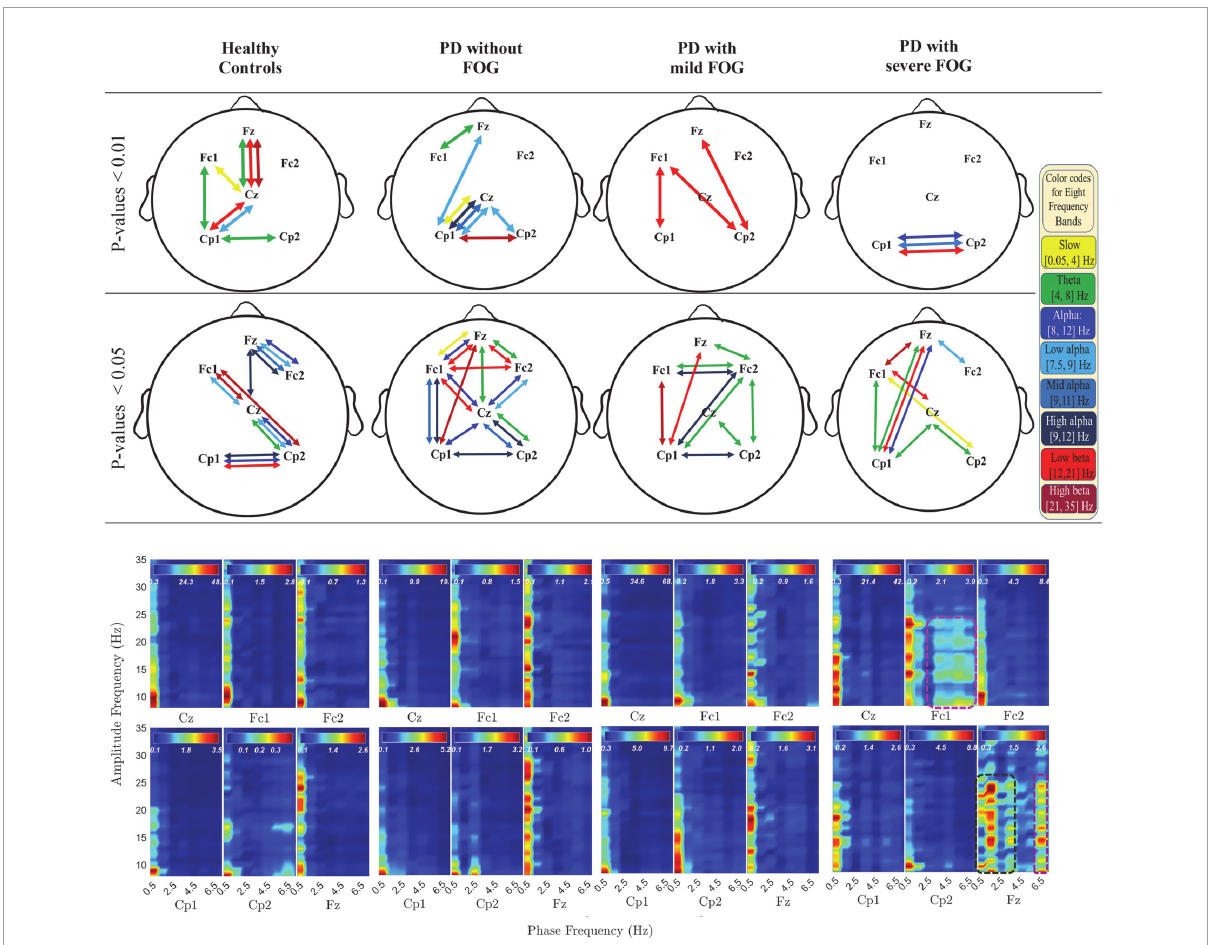
FIGURE2 Significant PLV between different channels over different frequency bands (top two rows) and PAC coupling between lower frequency bands (slow cortical potentials and theta) and higher frequency bands (alpha and beta frequency bands) (bottom row) with SL in all groups. In the top rows, different colors represent different frequency bands: Yellow: slow cortical potentials; green: theta; navy blue: alpha; light blue: low alpha; blue: middle alpha; dark blue: high alpha, light red: low beta; dark red: high beta. First and second row represent significant PLVs for p < 0.01 and p < 0.05, FDR-corrected, respectively. In the lower row, PAC between lower frequency bands (slow cortical potentials and theta) and higher frequency bands (alpha and beta frequency bands) with SL are presented over [–3, 1] s for all groups. Dashed pink lines represent the coupling of the phase of theta with alpha and low beta frequency bands. Dark green dashed lines represent the PAC between higher slow cortical potentials and alpha and beta in